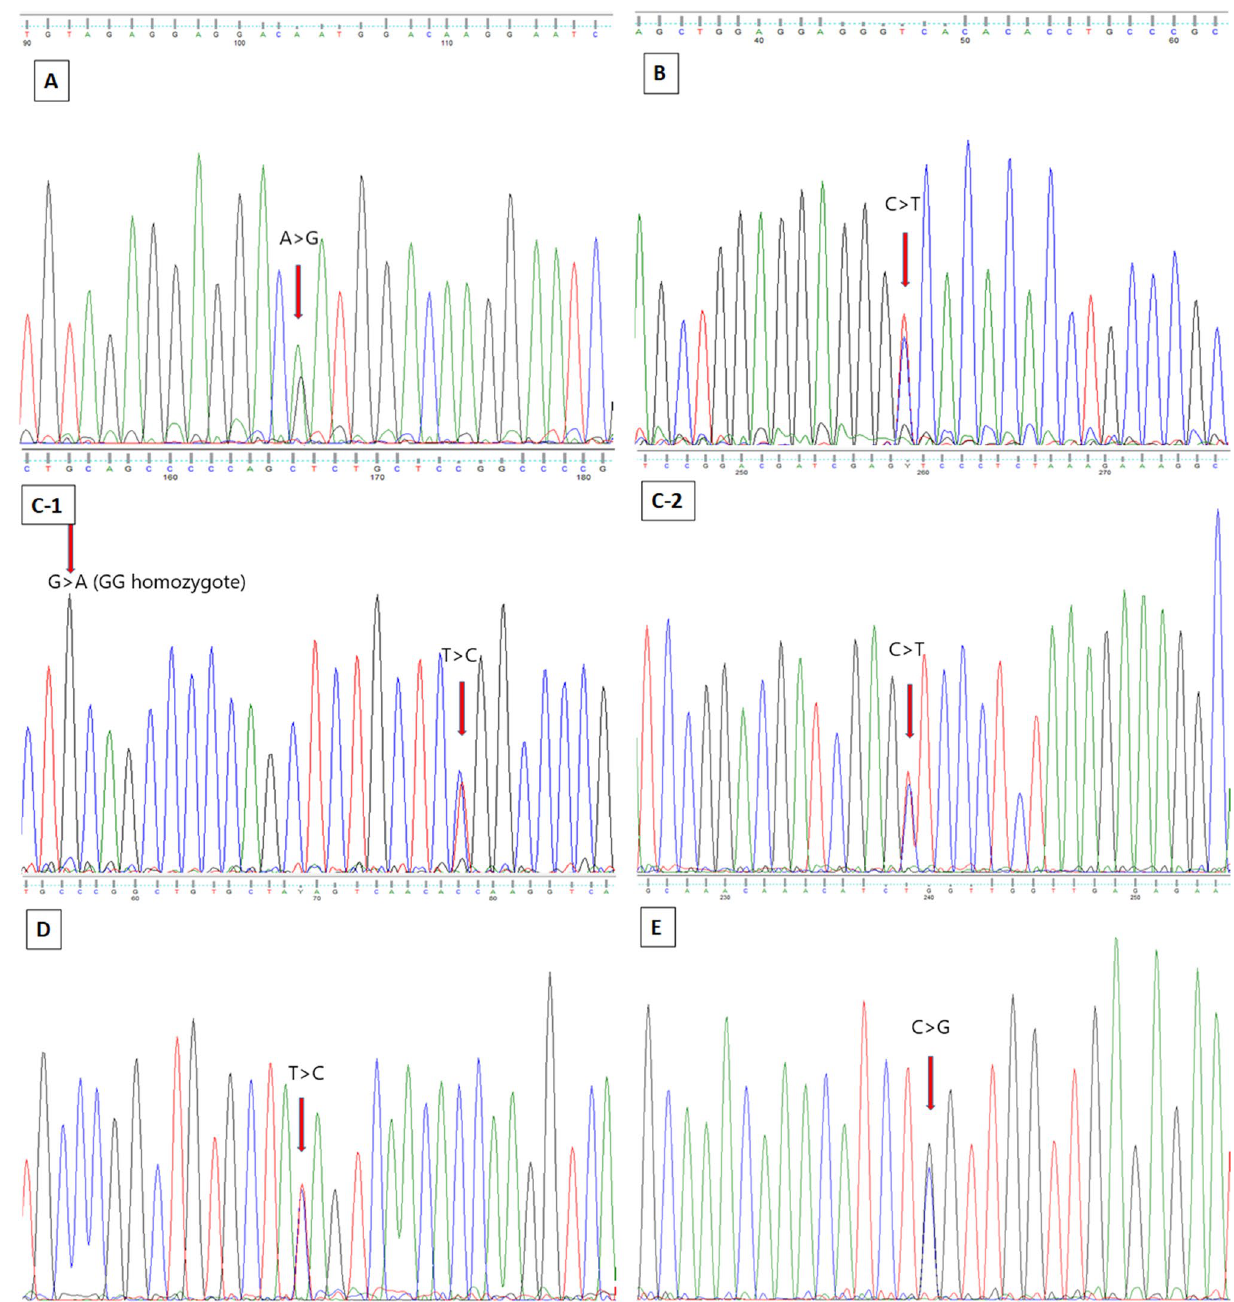
Figure 9. Exemplary Sanger sequencing chromatograms: ( A ) region 3, ssc-miR-9831, chr1 4108477 A>G; ( B ) region 6, ssc-miR-9853-1, chr12 57502421 C>T; ( C ) region 8, ssc-miR-9819, C-1: chr5 8348872 G>A (GG homozygote), 8348891 T>C; C-2: chr5 8348943, C>T; ( D ) region 17, ssc-miR-146b, chr 14 123301846 T>C; ( E ) region 20, ssc-miR-2483, chr X 117608224 C>G. The red arrow points to the given